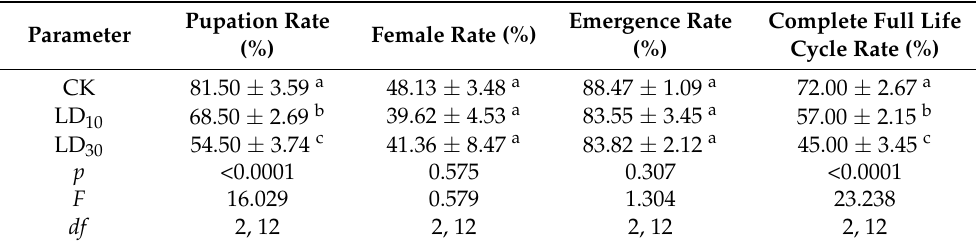
F = 23.238; df = 2, 14), respectively (Table 5). Other biological parameters including female rate and emergence rate were not significantly different among three treatments. Table 5. Sublethal effect of fluxametamide on biological parameters of F 0 C. suppressalis pupae and adults.